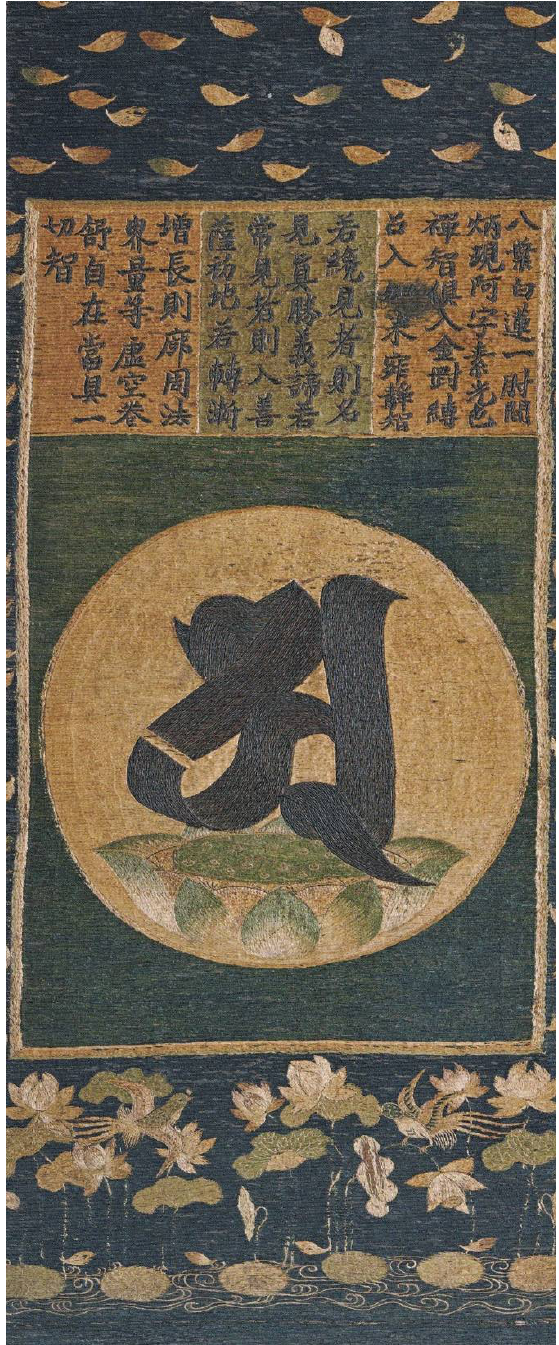
Figure 4. Sanskrit Seed-Syllable A, 14th century. Hair and silk thread embroidery on plain weave silk, Shōchi-in, Wakayama Prefecture, Height: 69.5 cm, Width: 32.7 cm. Source: Ito no mihotoke, Nara National Museum (Nara: Nara National Museum, 2018, 190).